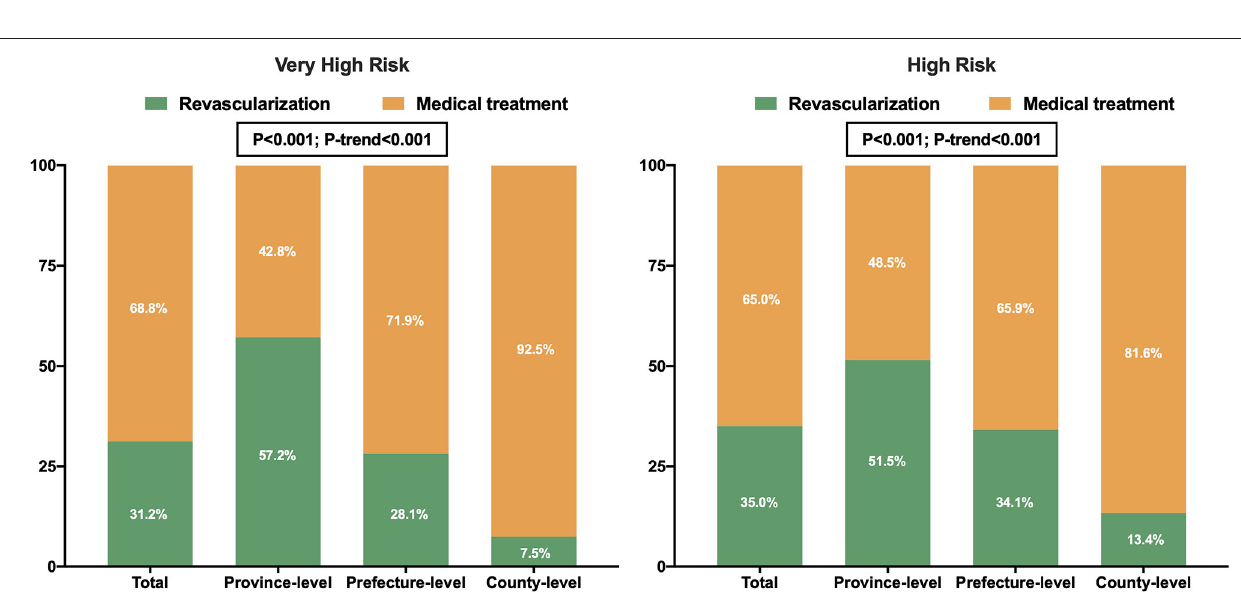
FIGURE 3 | Revascularization rates in patients with NSTEMI according to the guideline-recommended risk criteria among the three hospital levels in